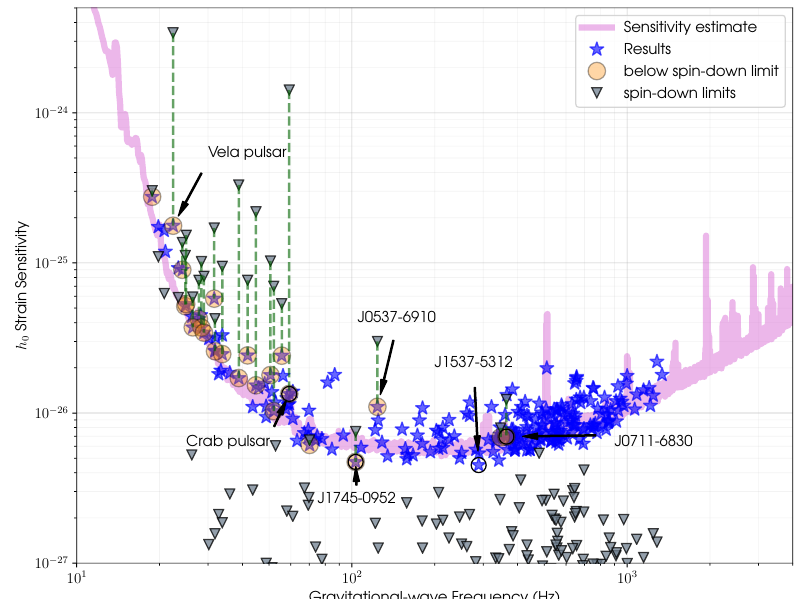
Figure 2. Upper limits on h 0 for the 236 pulsars in the targeted search in [222] are relative to the time-domain Bayesian method. The stars show 95% credible upper limits on the amplitudes of h 0 . Grey triangles represent the spin-down limits for each pulsar computed as in Equation (11). Pulsars with upper limits surpassing their spin-down limits are marked with yellow circles. The pink curve gives an estimate of the expected strain sensitivity of all three detectors combined during the course of O3. Figure taken from